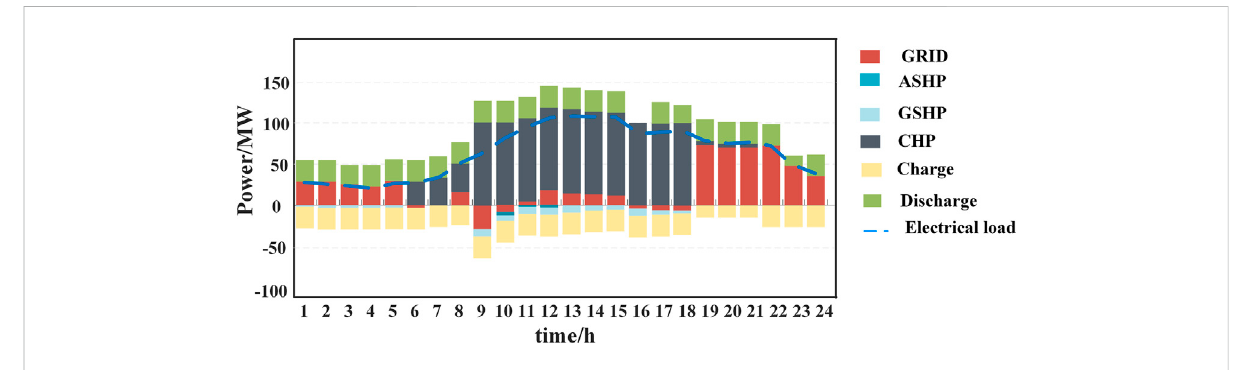
FIGURE 8 The optimal electricity operation strategies in spring.